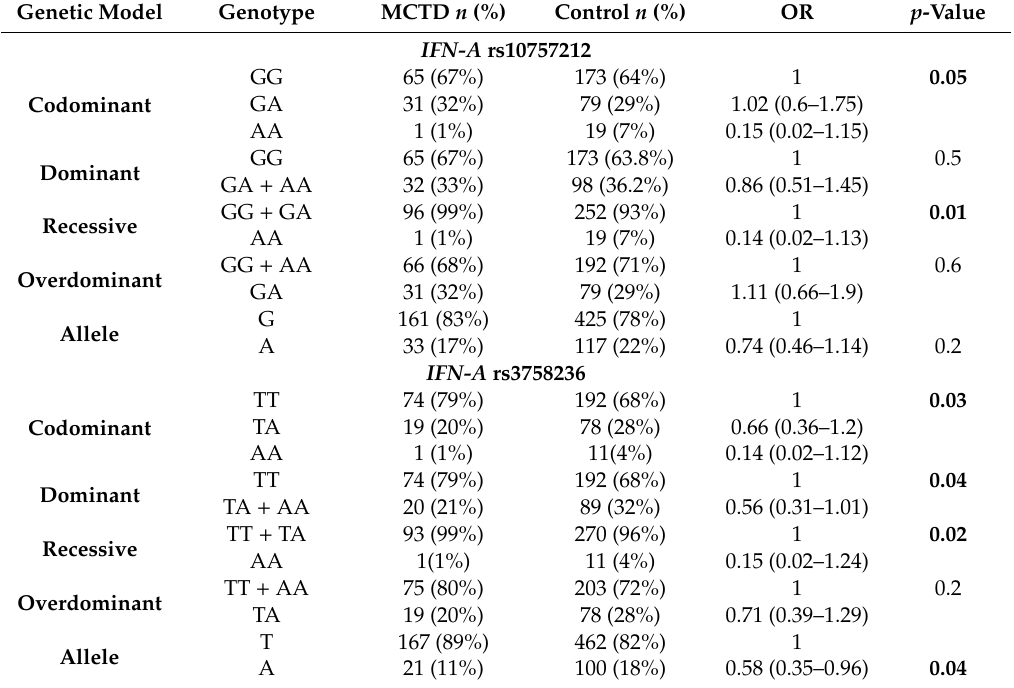
Table 3. Genotype distribution and allele frequencies of the interferons (IFNs) polymorphisms in MCTD patients and healthy subjects (adjusted by sex and